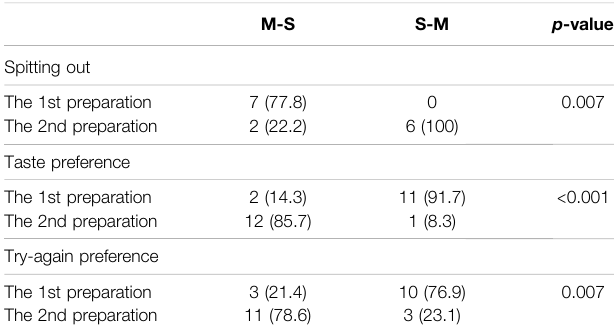
TABLE 2 | The comparisons of spit-out and taste interviews between two administration sequences of carbocysteine oral solution for mint taste (M) and strawberry taste